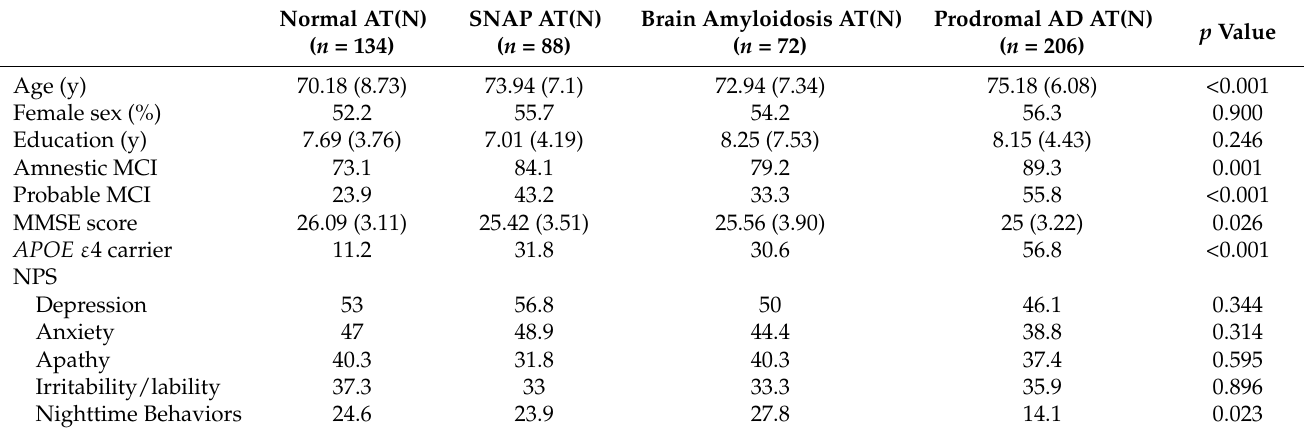
Table 2. AT(N) profiles and their associations with demographic and clinical variables.